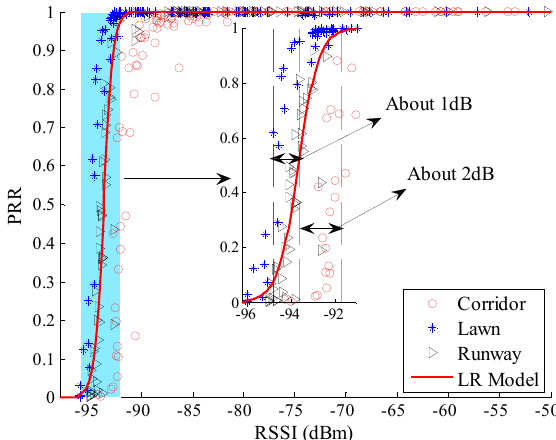
Figure 10. Effects of the logistic regression (LR) model in different environments.